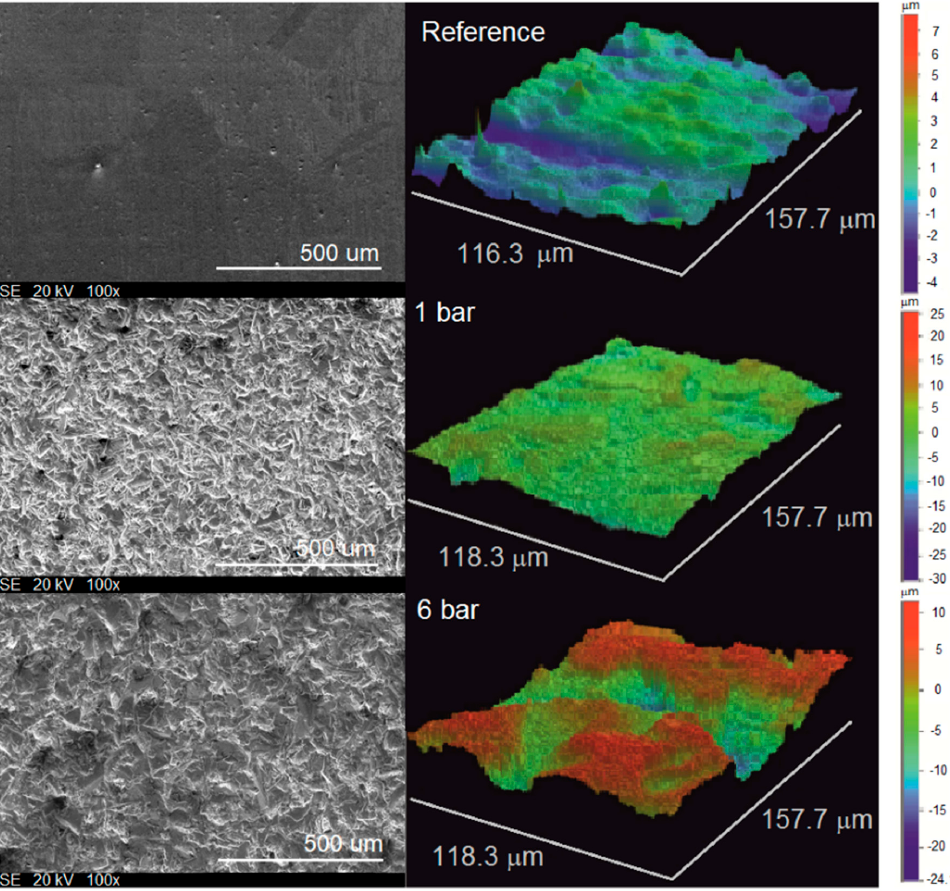
Figure 3. SEM and optical images of reference and sandblasted copper specimens at 1 and 6 bar.